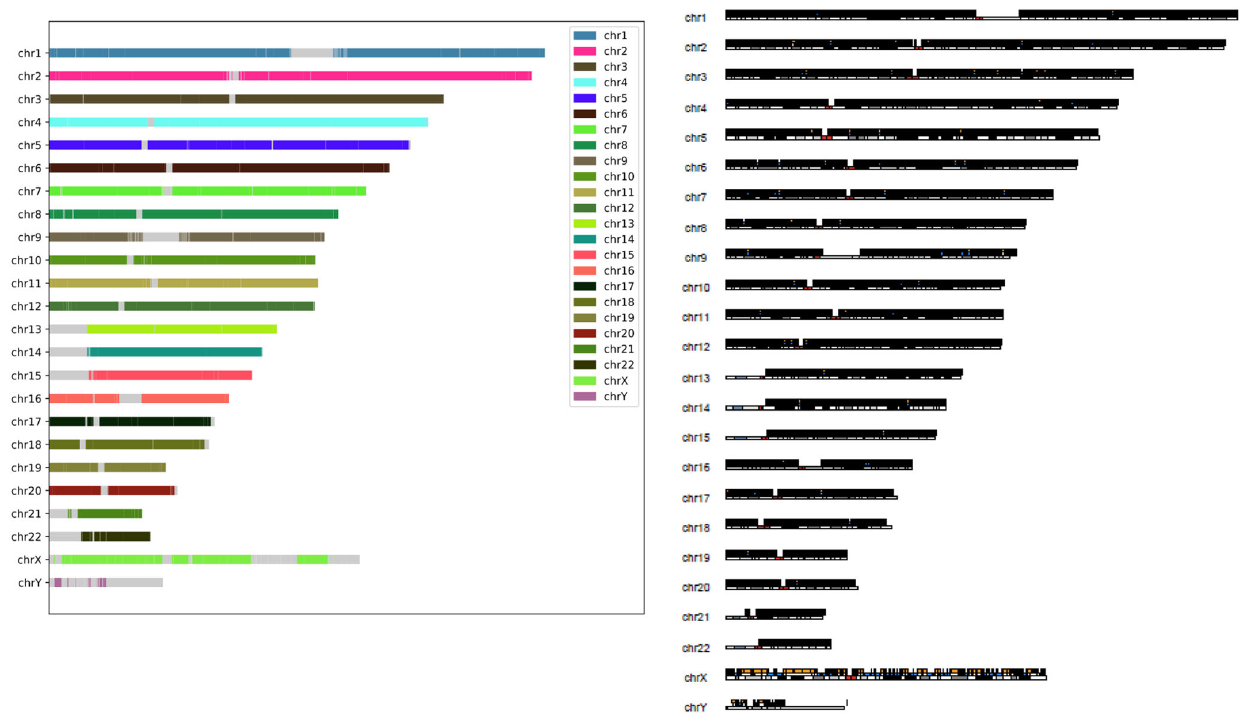
Fig. 4 | Ideogramofphased sequencesofHG002(left) and COLO829 (right). One colour foreach chromosome representing chromosome level. Nocolour represents gaps for complex regions, for example, centromeric, acrocentric,